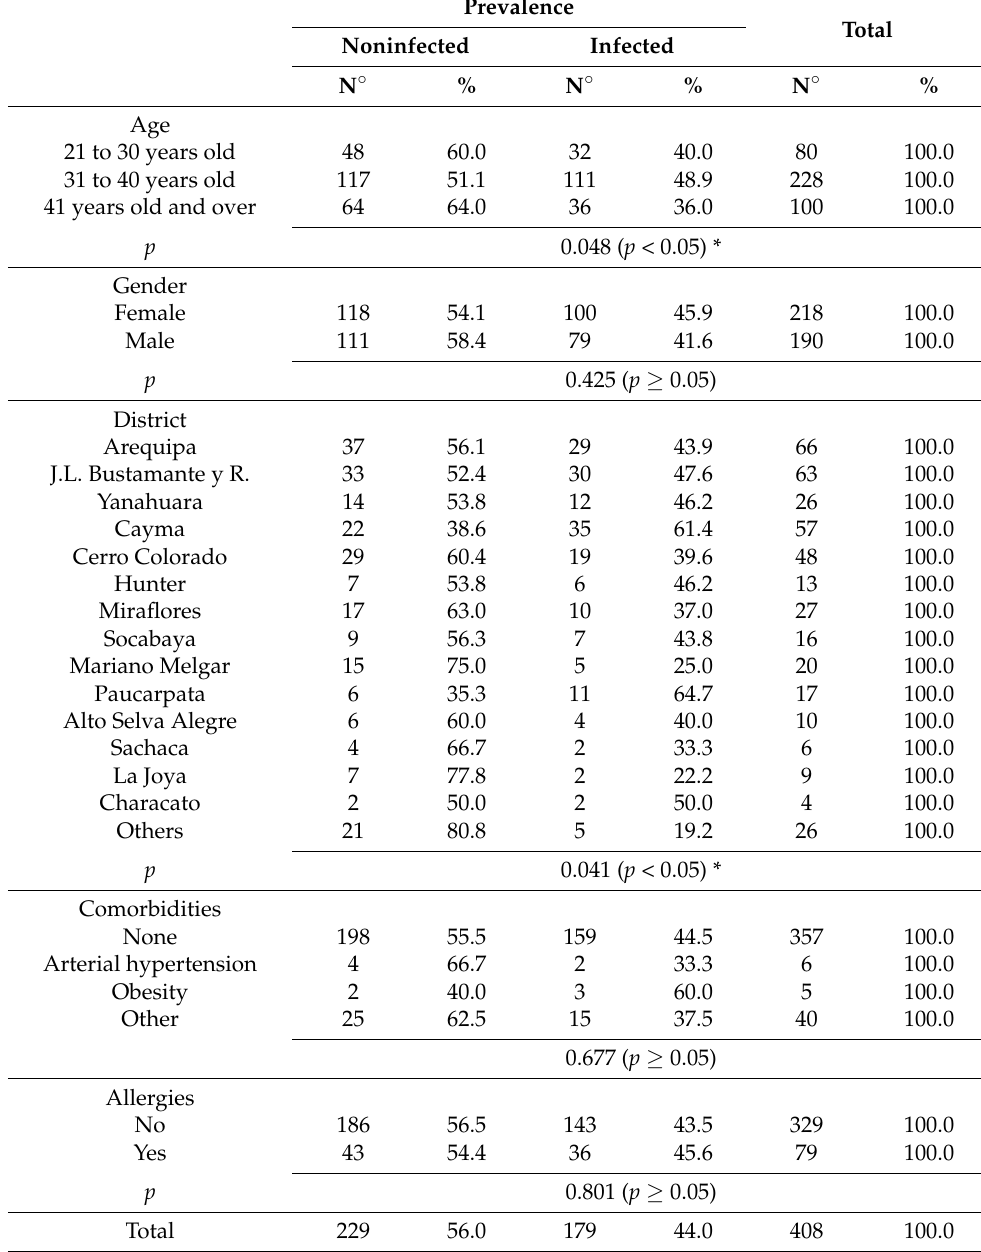
Table 1. Sociodemographic characteristics of the dentists